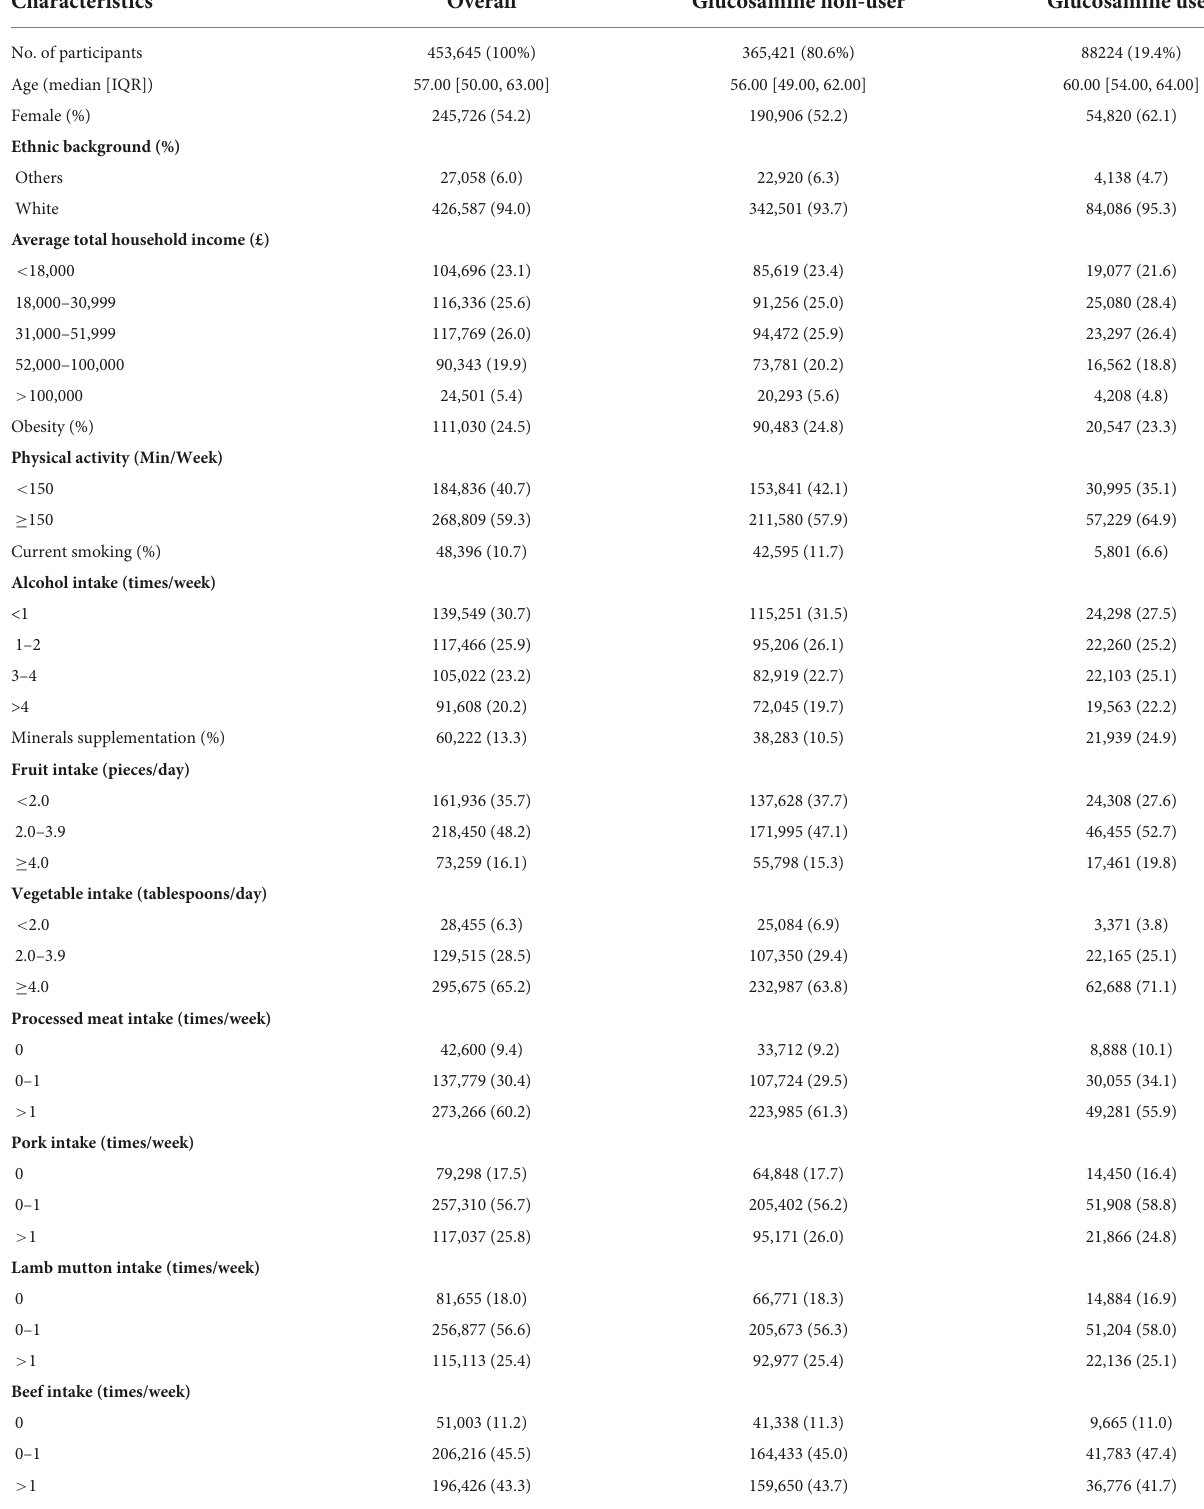
TABLE 1 Baseline features for UK Biobank participants by glucosamine